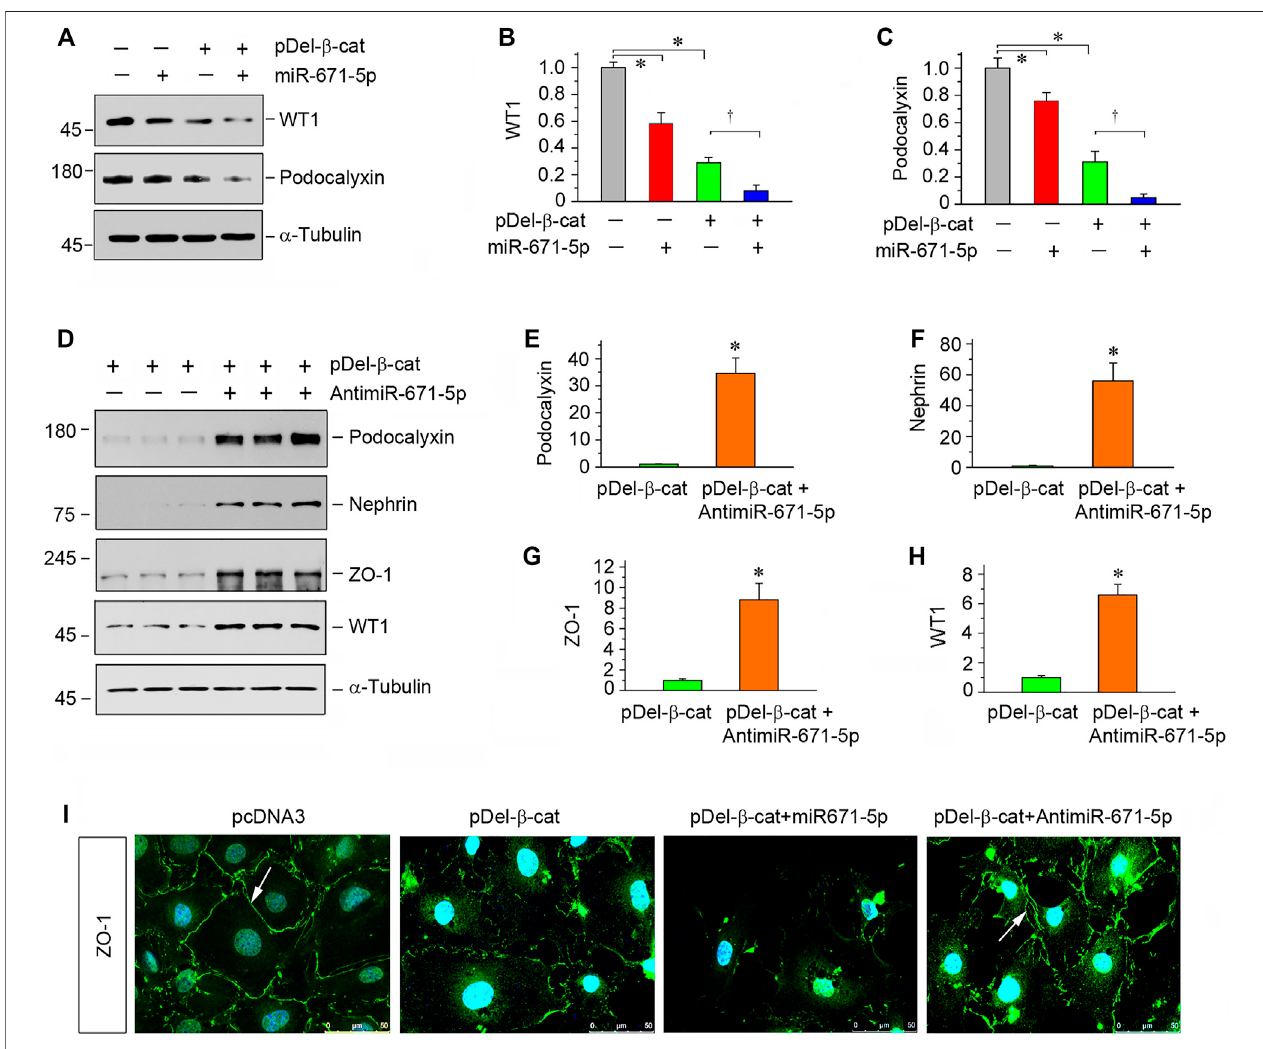
FIGURE 3 | miR-671-5p aggravates β -catenin-induced podocyte injury while miR-671-5p inhibitor ameliorates it in vitro . (A – C) Representative Western blot (A) and graphic presentations of WT1 (B) and podocalyxin (C) were presented. MPC5 cells were transfected with miR-671-5p mimics (miR-671-5p) or/and β -catenin expression plasmid (pDel- β -cat) for 24 h * p < 0.05 versus pcDNA3 controls; † p < 0.05 versus pDel- β -cat ( n (cid:1) 3). (D – H) Representative Western blot (D) and graphic presentations ofpodocalyxin (E) , nephrin (F) , ZO-1 (G) and WT1 (H) were presented. MPC5 cells were transfected with β -catenin expression plasmid (pDel- β -cat) or/and miR-671-5p inhibitor (AntimiR-671-5p) for 24 h * p < 0.05 ( n (cid:1) 3). (I) Representative micrographs show the expression of ZO-1 in different groups as indicated. MPC5 cells were transfected with β -catenin expression plasmid (pDel- β -cat) and miR-671-5p mimics (miR-671-5p)/miR-671-5p inhibitor (AntimiR-671-5p) for 24 h, respectively. Scale bar, 50